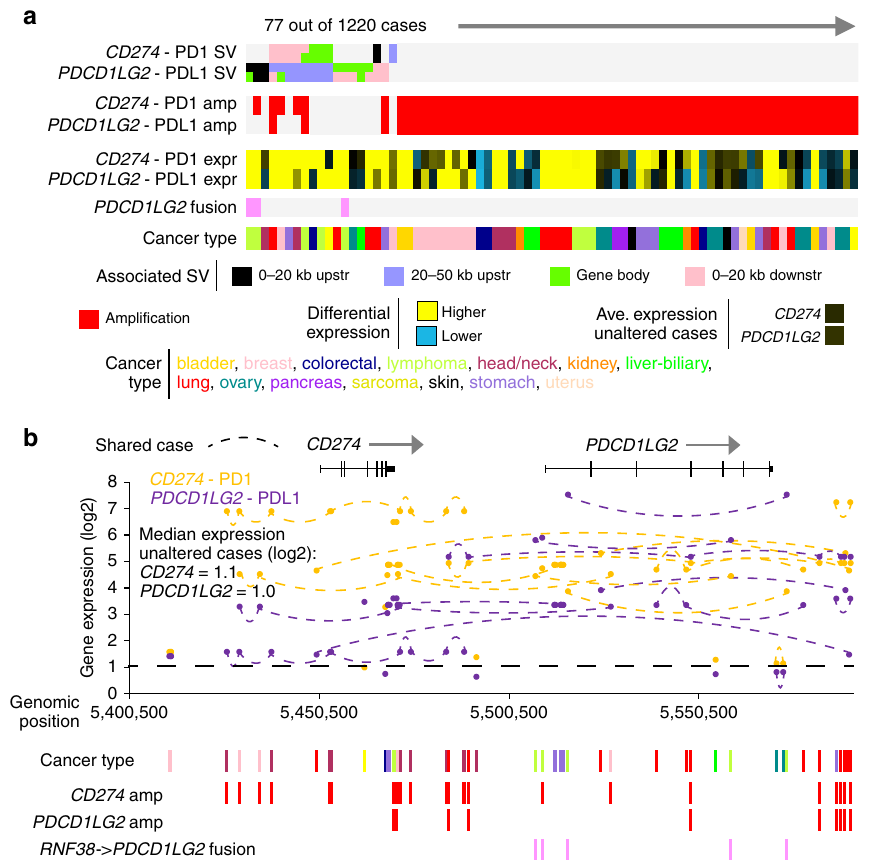
Fig. 4 SVs associated with PD1/PDL1 genes and their increased expression. a Patterns of SV, gene ampli fi cation (5 or more copies), RNF38 -> PDCD1LG2 gene fusion, and differential expression for CD274 (PD1 gene) and PDCD1LG2 (PDL1 gene), for the subset of cases with associated SV or ampli fi cation for either gene. Differential gene expression patterns relative to the median across sample pro fi les. b Gene expression levels of CD274 and of PDCD1LG2 , corresponding to the position of SV breakpoints located in the surrounding genomic region on chromosome 9 (representing 66 SV breakpoints involving 19 cases). Median expression for unaltered cases represents cases without SV or ampli fi cation. See also Supplementary Data 4.